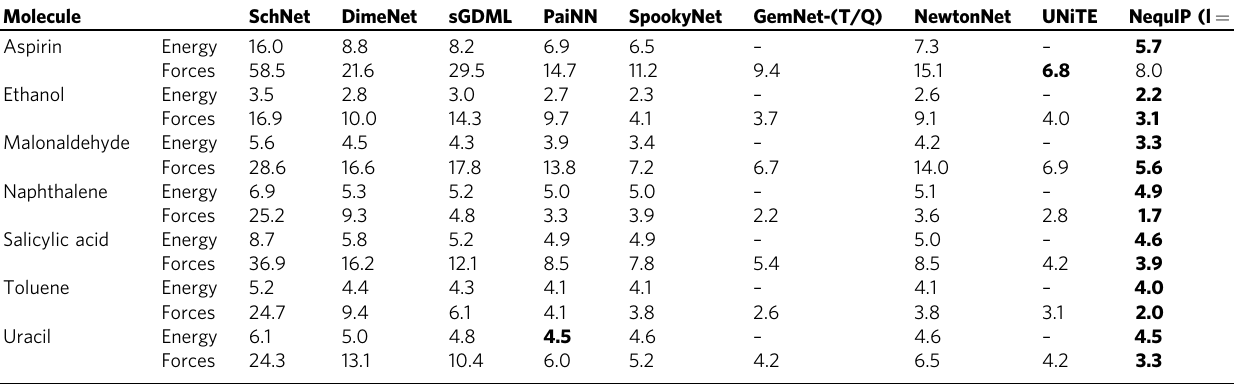
For GemNet, the best result out of the T/Q versions is presented and for PaiNN the best between force-only and joint force and energy training. For UNiTE, we compare to the “ direct-learning ” results reported in 26 . Best results are marked in bold.